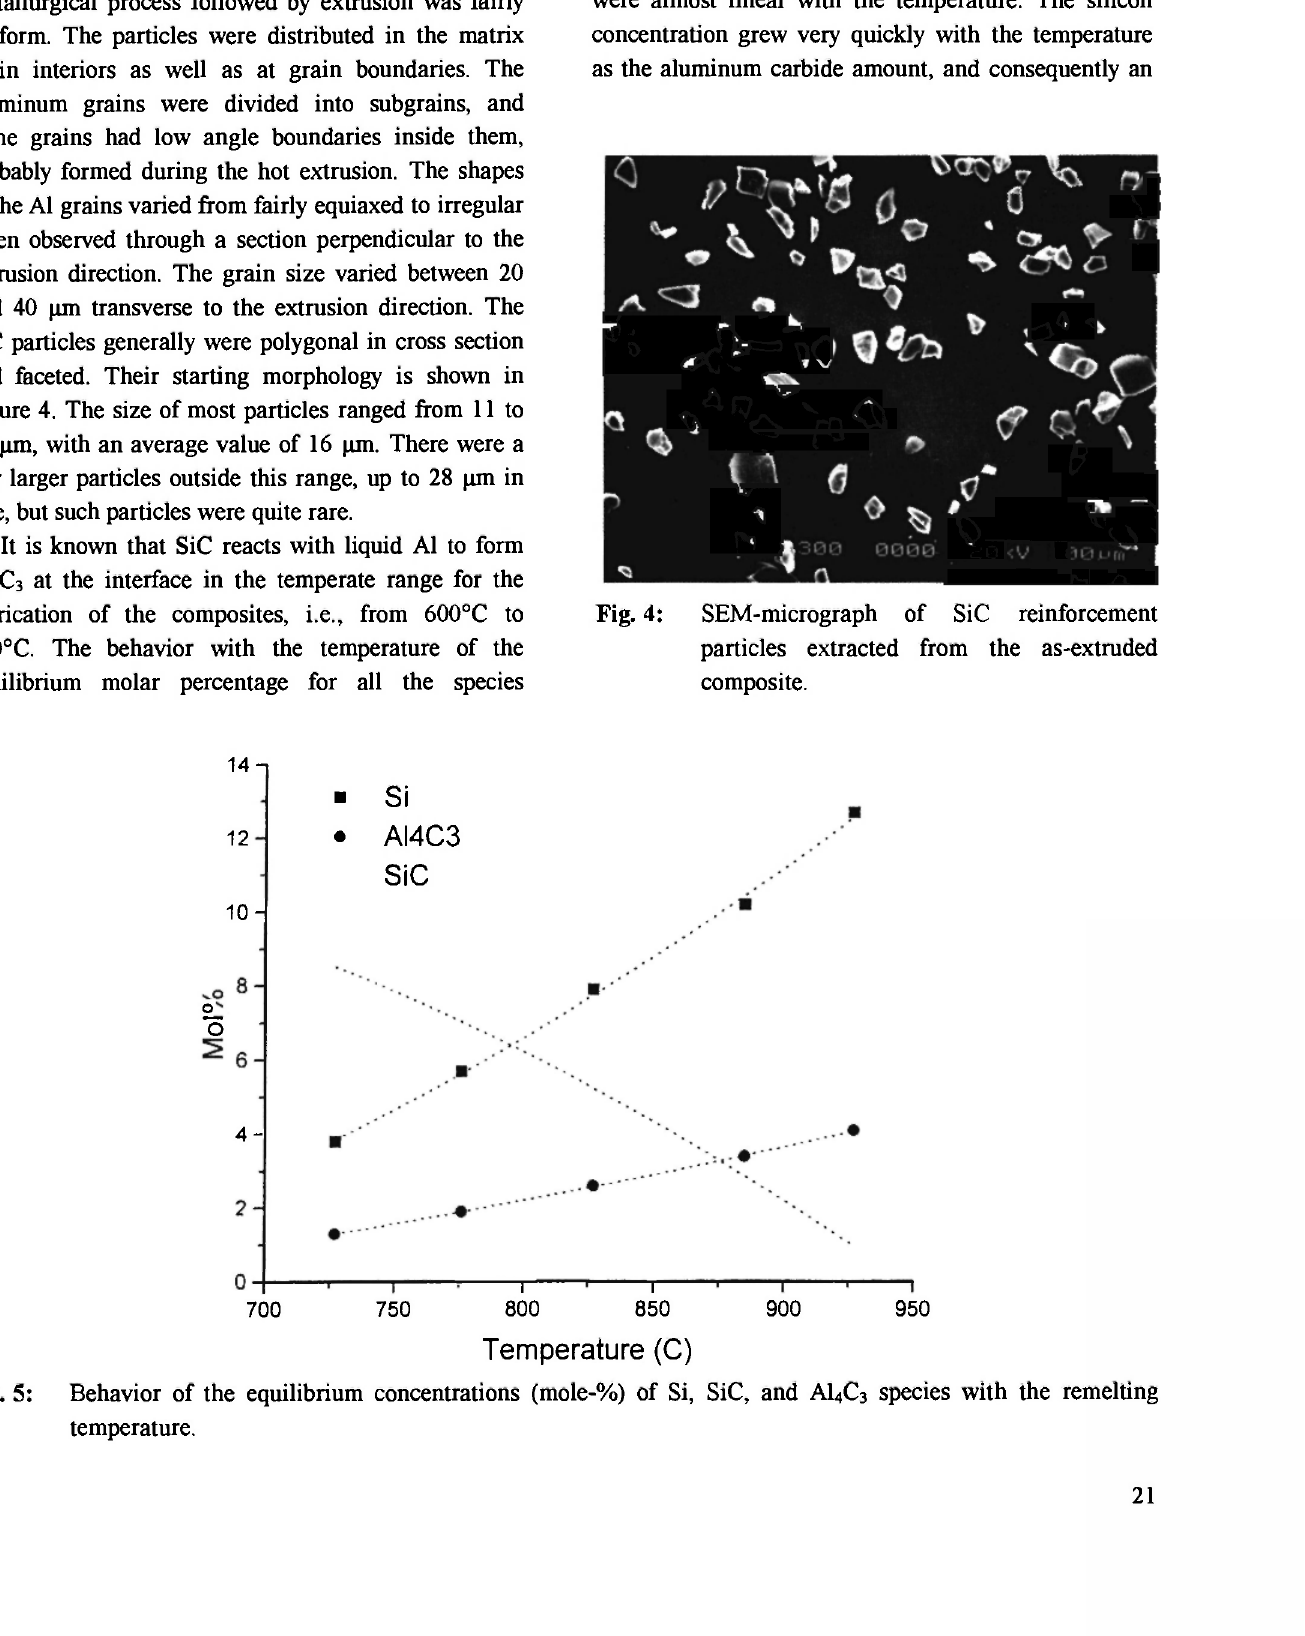
800 Temperature (C)